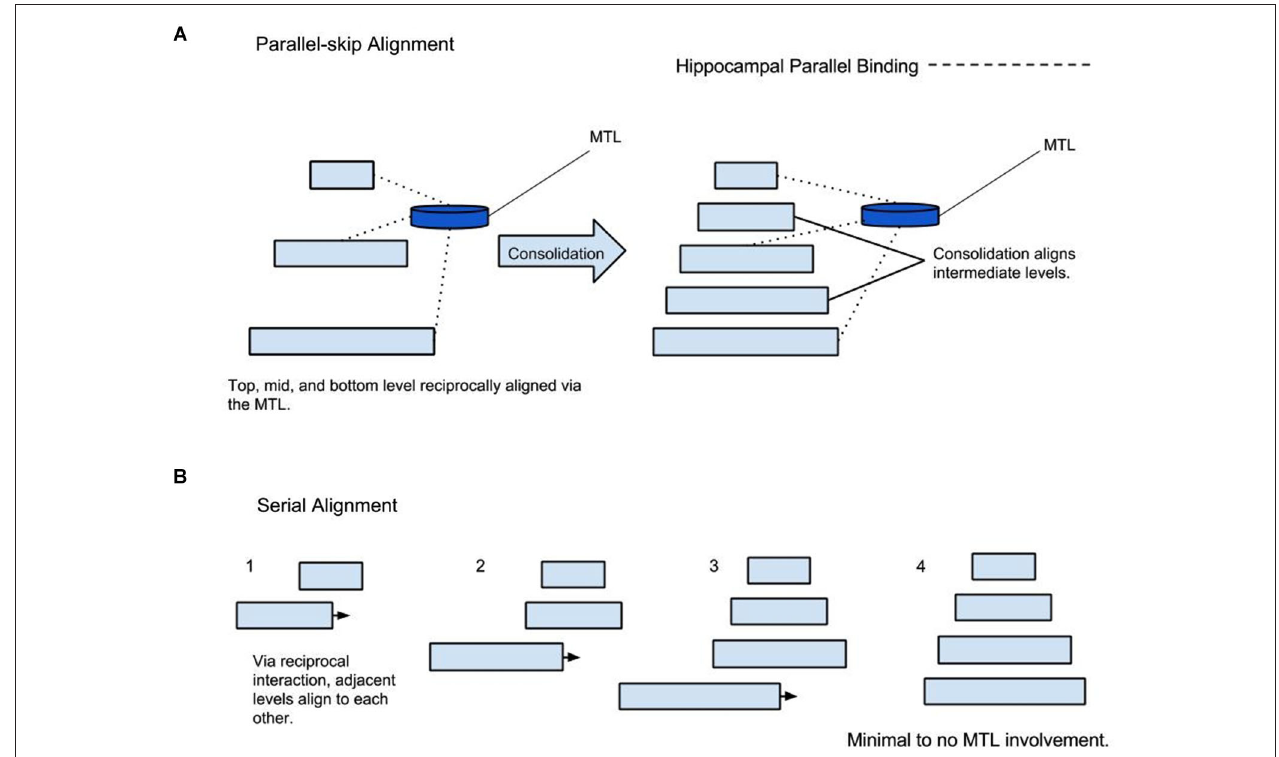
FIGURE 2 | Parallel and Serial Alignment. (A) Parallel alignment of hierarchy levels mediated by the MTL followed by consolidation. (B) Demonstrating serial alignment of a completely consolidated representation without the MTL